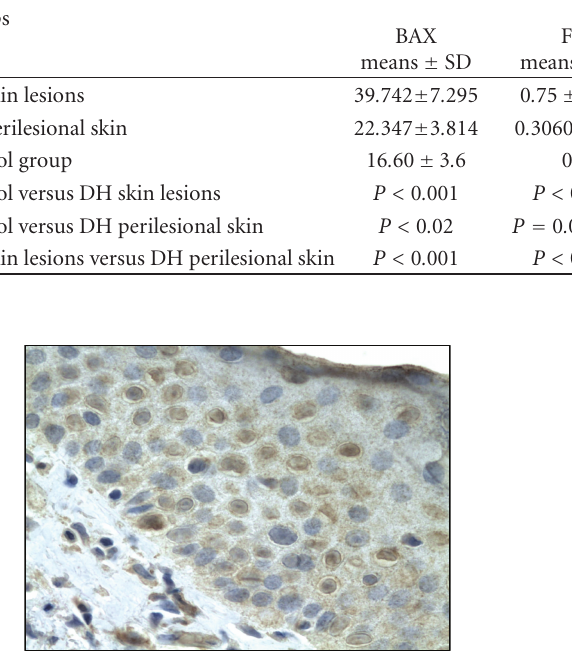
Figure 5: TRAIL receptor immunoexpression in skin lesions, (score 2),